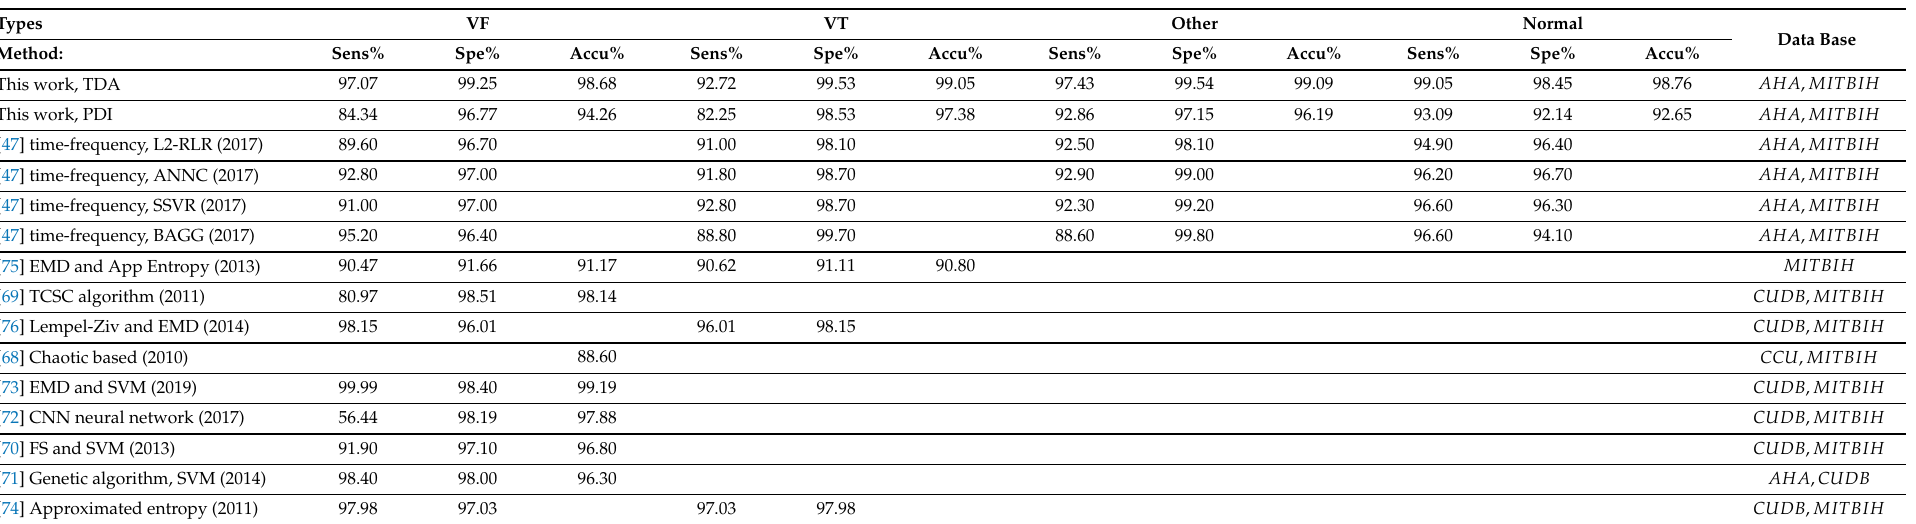
Table 11. Performance results comparison with other rhythm-discriminating